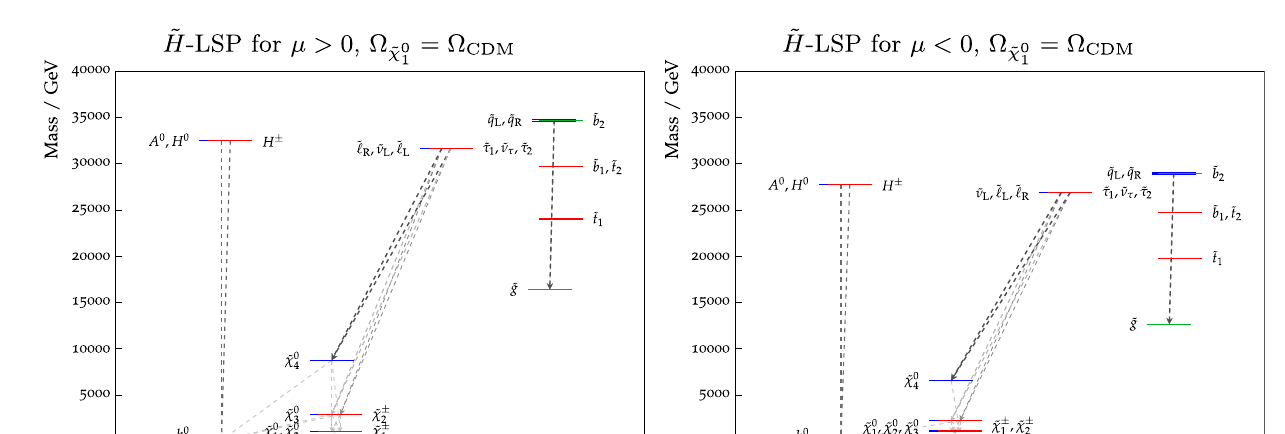
Fig. 10 The spectra of our best-fit points for μ > 0 ( left panel ) and μ < 0 ( right panel ), assuming that the LSP makes the dominant con- tribution to the cold dark matter density. Both the wino-like ( upper ) and the Higgsino-like LSP ( lower ) best-fit points are shown. In each